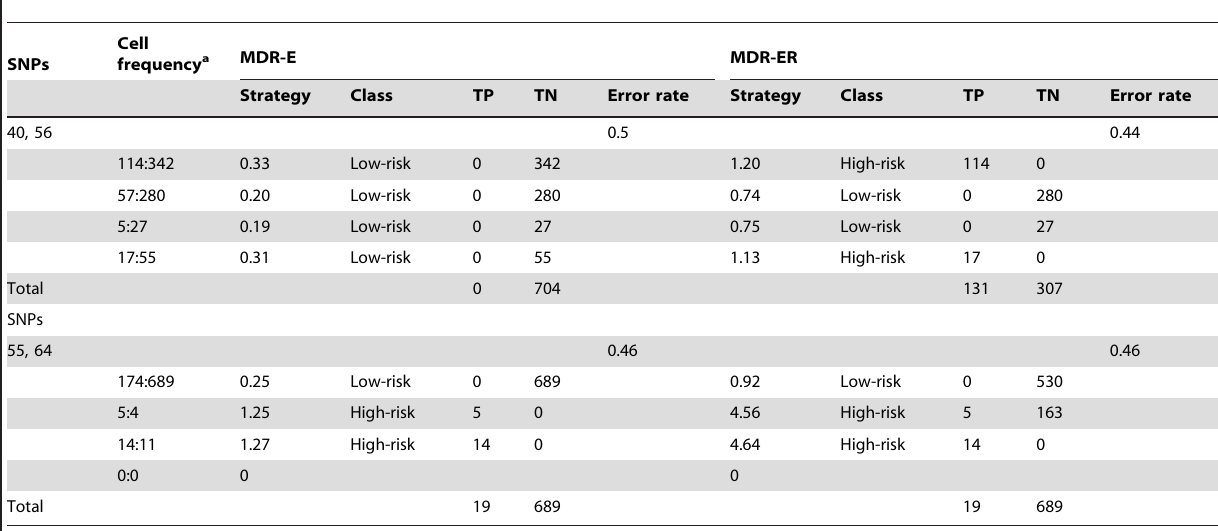
a the left number represents the number of cases and the right number represents the number of controls.